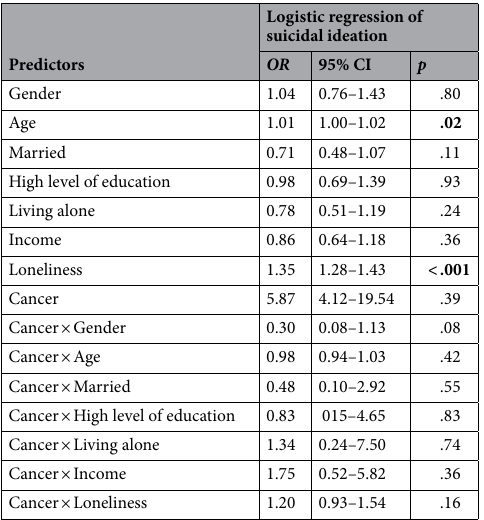
Table 4. Multiple logistic regression of suicidal ideation (PHQ-9 item). Nagelkerke R 2 = 0.25. OR = Odds Ratio. CI = Confidence Interval. Significant values are in